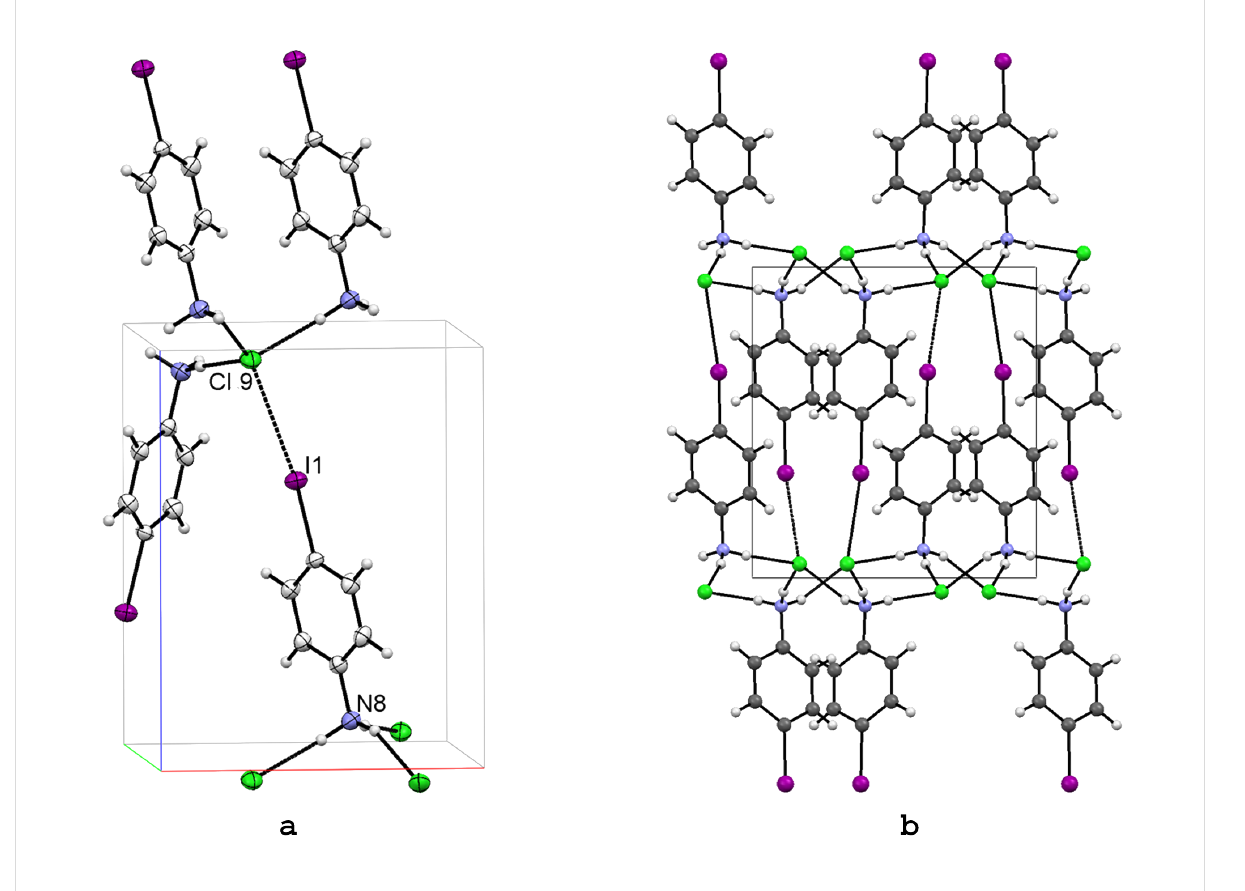
Figure 1: X-ray structure of 4-IPhNH 3 Cl ( 1 ) with numbering for selected atoms (a) and the packing scheme viewed down the a axis (b). Thermal ellipsoids are shown at the 50% probability level. Hydrogen and halogen bonds are shown in dotted lines.